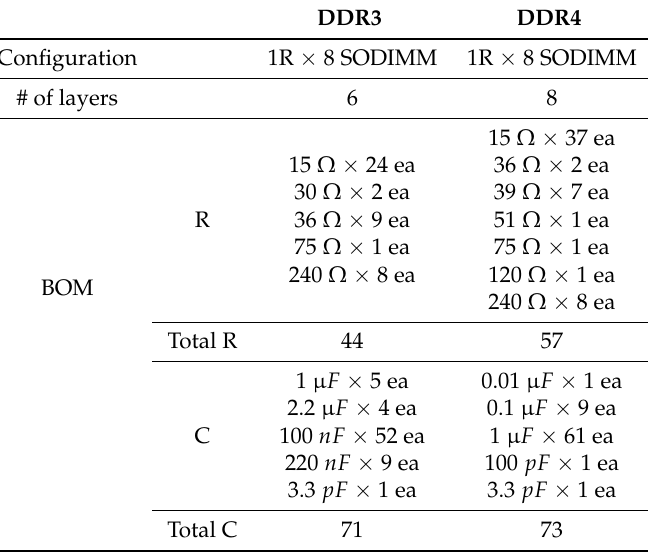
Figure 8. DDR3 vs. DDR4 stack-up: ( a ) DDR3; and ( b ) DDR4. Table 2. Bill of materials (BOM) details of memory